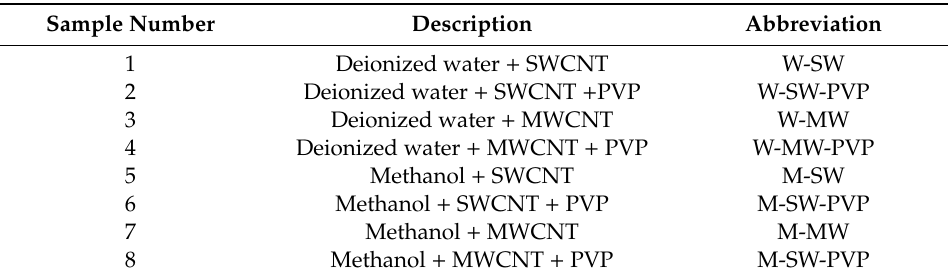
Table 1. Aqueous samples studied in this report. For all cases, the CNTs concentration was 2.5 mg / mL. The samples with PVP were prepared at a concentration of 50 mg /